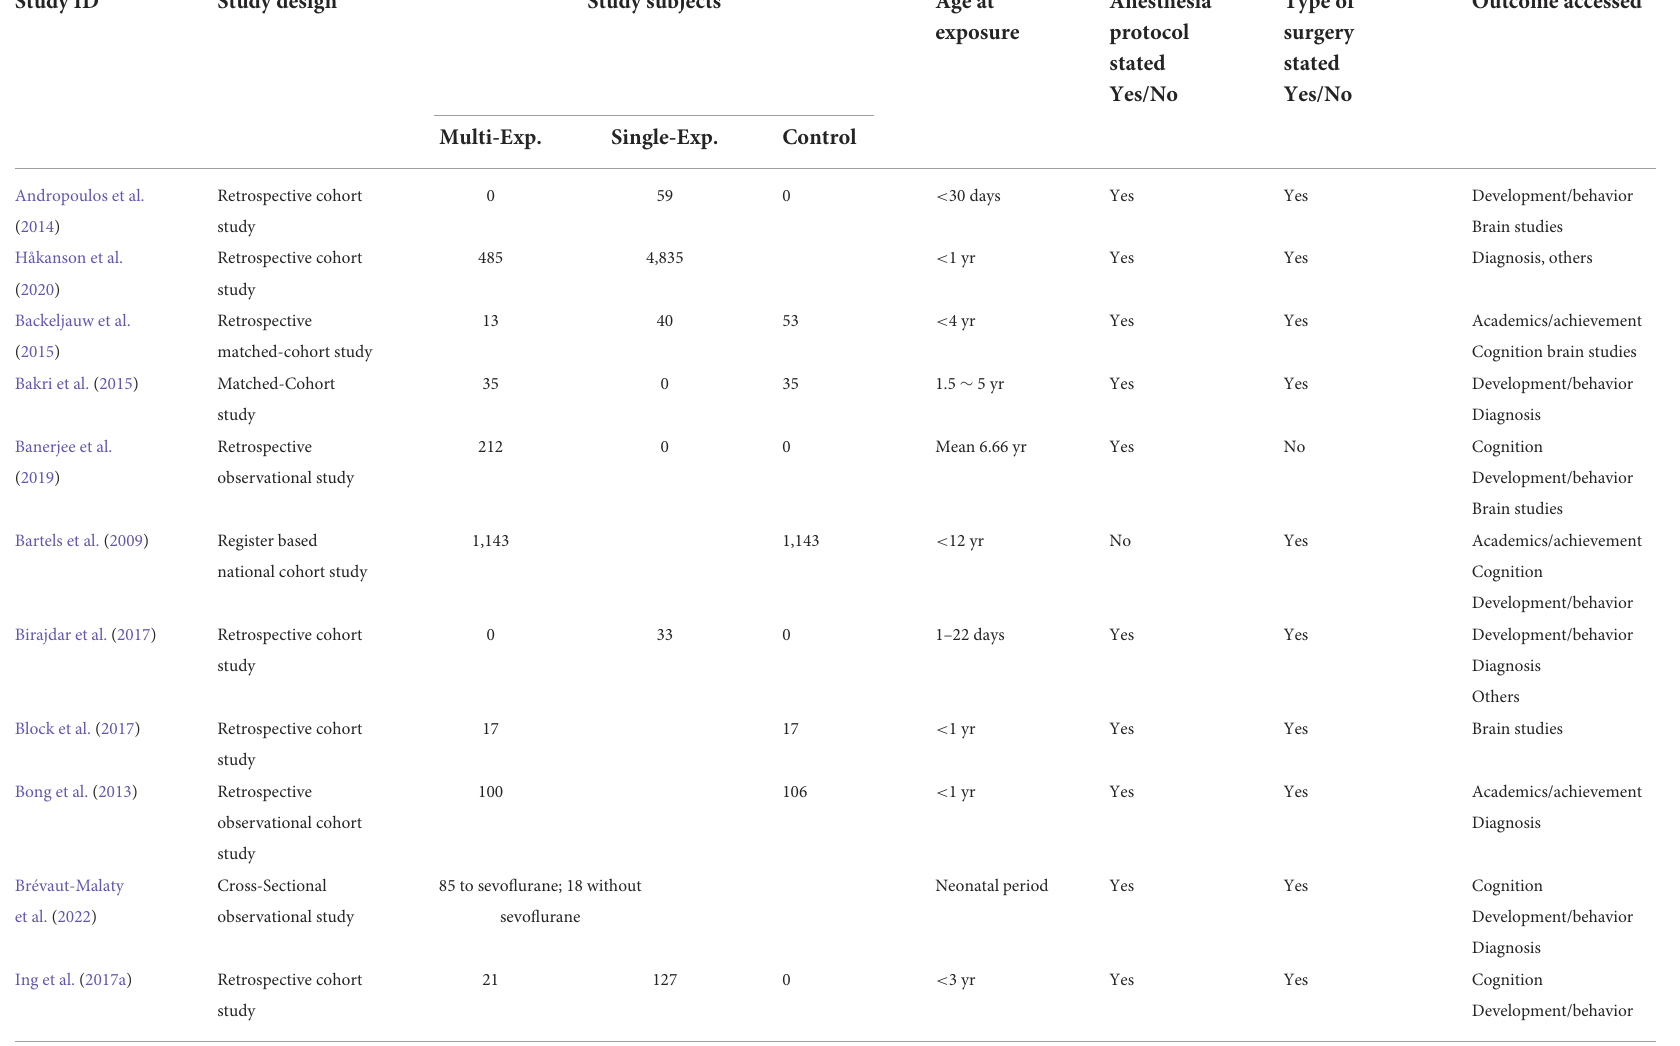
TABLE 1 Summarized characteristics of studies included in the current